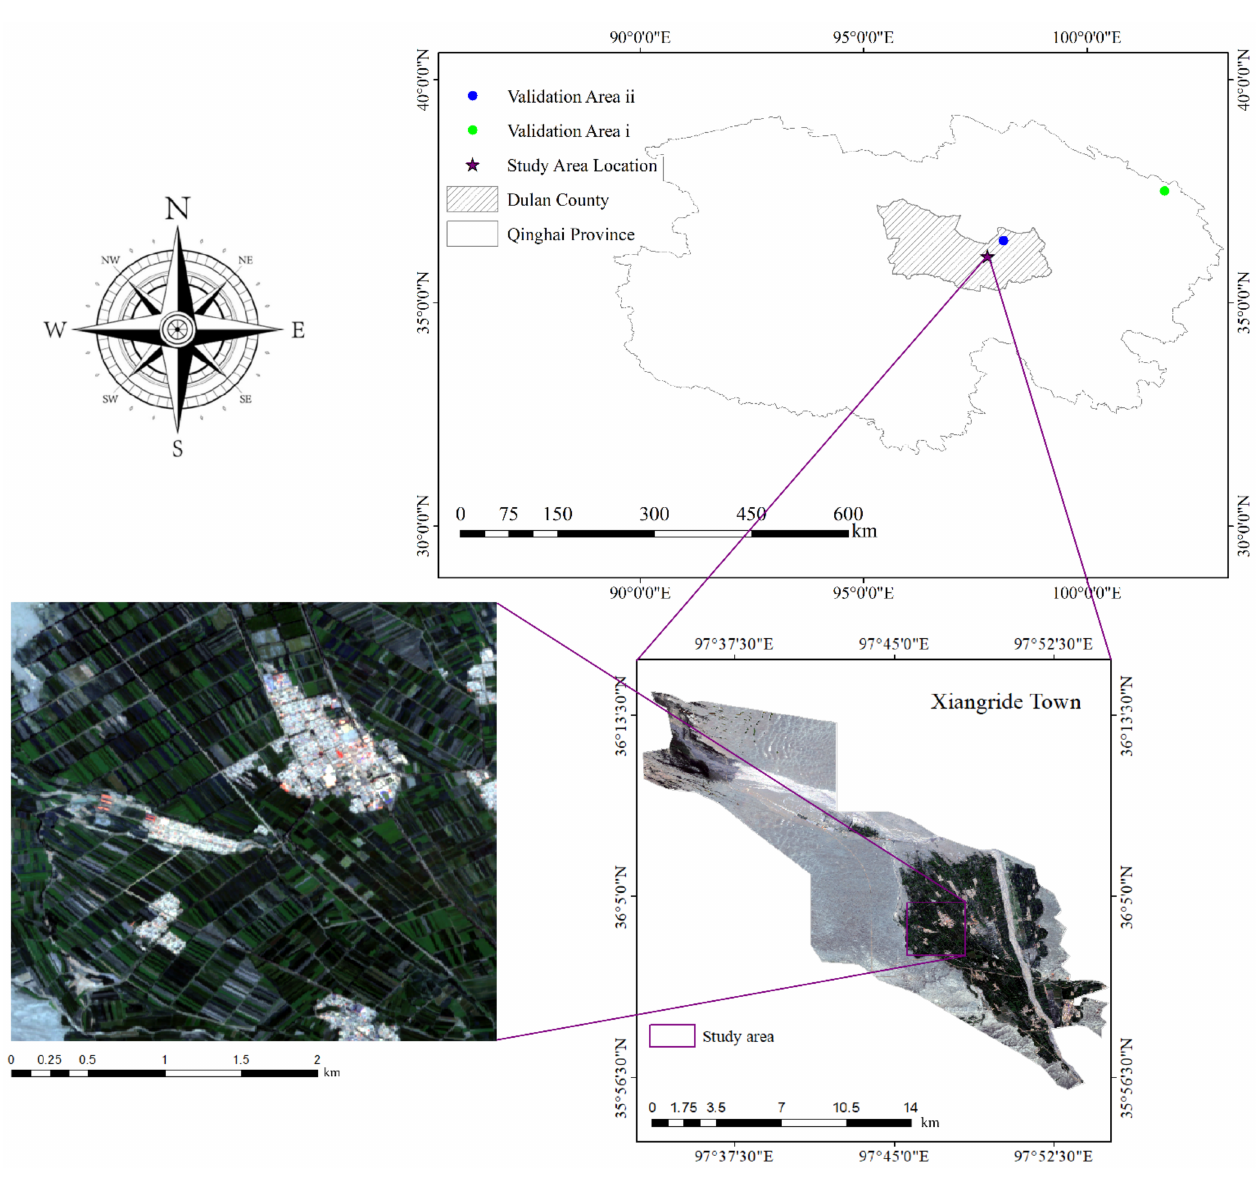
Figure 1. Sentinel-2 image of the study